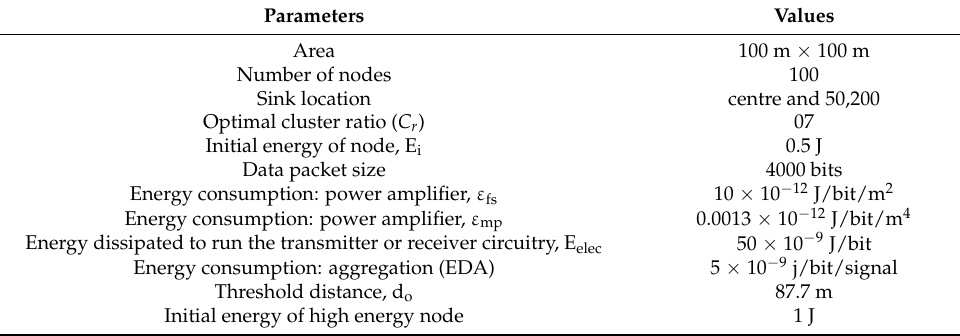
Table 1. Simulation parameters for FEHCA. Parameters